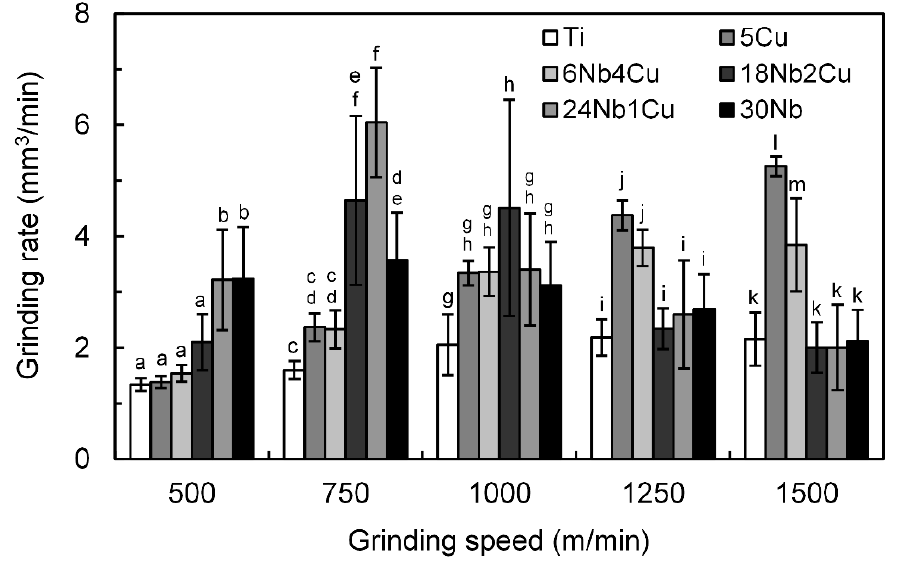
Figure 3. Grinding rates for Ti − Nb − Cu alloys. At a particular grinding speed, identical roman letters indicate a statistically insignificant difference ( p > 0.05) between the grinding rates for titanium and the alloy, whereas different letters indicate a statistically significant difference.